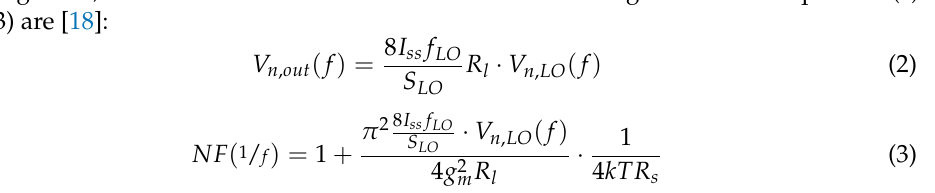
I D3 . Increasing in the driver stage current (I D1 ) forces the reduction of load resistance R L